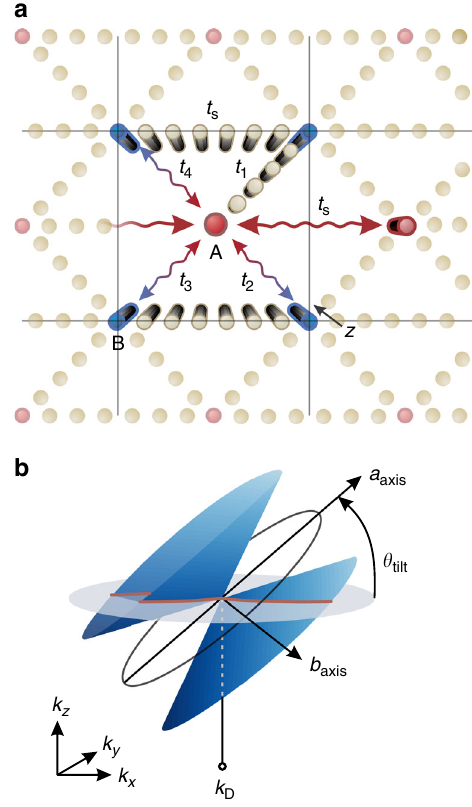
Fig. 1 Chained square lattice of photonic waveguides and tilted type-II Dirac cone. a The anisotropic square lattice with fi ve independent hopping terms between sites A and B. Each term is associated with a unique waveguide chain that regulates its magnitude (here, we explicitly draw t 1 and t s ). Light propagates towards the z direction, with momentum k z imposed by the eigenvalues of the quasi-relativistic model. b The generalized Dirac cone, located at k D, is characterized by the amount of anisotropy ( a / b ) and degree of tilting ( θ tilt ). The plane of anisotropy is in general separate from the θ tilt plane. These properties are directly governed by the hopping terms introduced in a